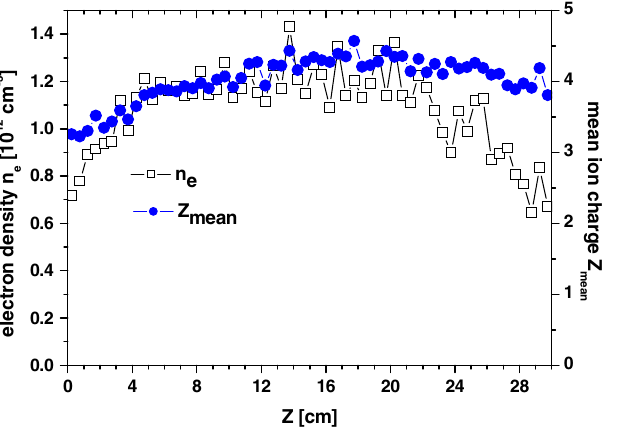
FIG. 5. (Color) Electron density (left scale) and mean ion charge state (right scale) at the axis of the source as a function of z